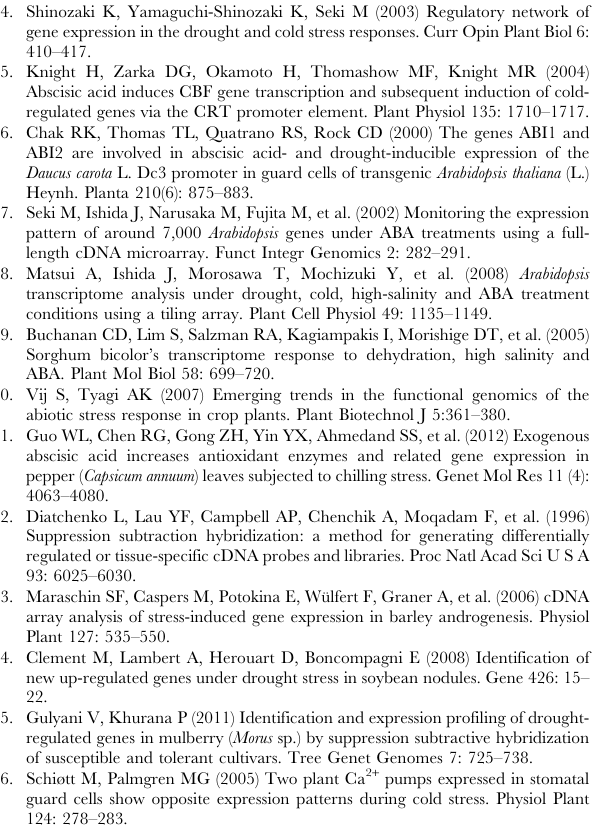
Figure S3 mRNA isolated from pepper seedlings sub- jected to chilling stress. Lane 1, mRNA from ABA-pretreated leaves under chilling stress; Lane 2, mRNA from water-pretreated leaves under chilling stress; M: DNA size marker. (TIF) Figure S4 Results of SSH using leaves as testers and drivers. This shows the secondary PCR products. Lane 1, reverse-unsubtracted leaves cDNA; lane 2, forward-unsubtracted leaves cDNA; lane 3, reverse-subtracted leaves cDNA; lane 4, forward-subtracted leaves cDNA. M: DNA size marker. (TIF) Figure S5 A few inserts of subtracted cDNA clones of leaves amplified by PCR. Lanes 1–7 show 7clones randomly selected from the subtracted library. M: DNA size marker. (TIF) Table S1 The accession numbers of ABA-regulated unigenes in pepper plants under chilling stress. Table S2 Primer sequences for